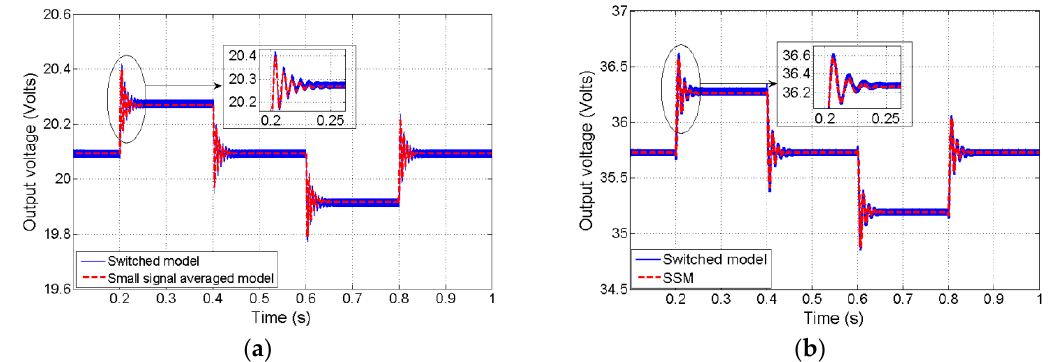
Figure 4. Simulated SSM and switched model output voltage curves in the case of 4% DR perturbation: ( a ) around 30%, and ( b ) around 60% DRs.